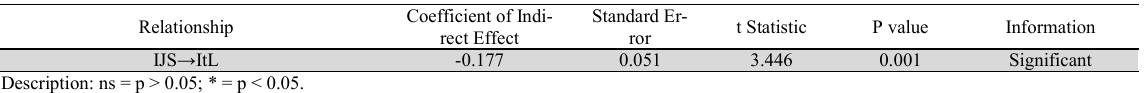
Fig. 2. Mediation Path of Organizational Commitment, processed data (2018) Indirect Influence Test